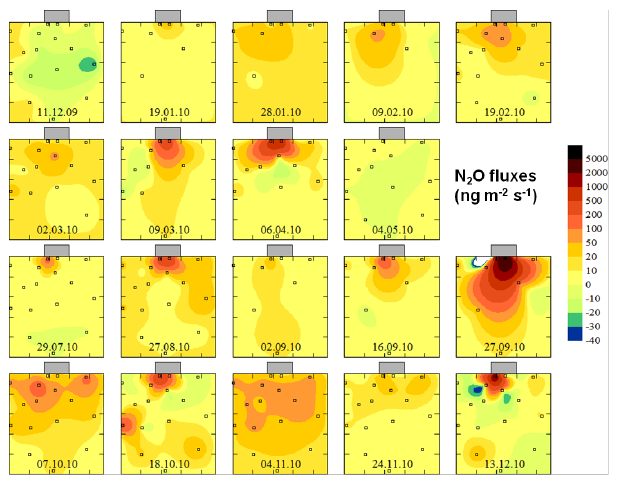
Fig. 3. Spatially interpolated (kriging method) maps of N 2 O fluxes. For each measurement day, the kriging was done on the basis of the available chamber measurements as shown by the number of chambers displayed in each map.